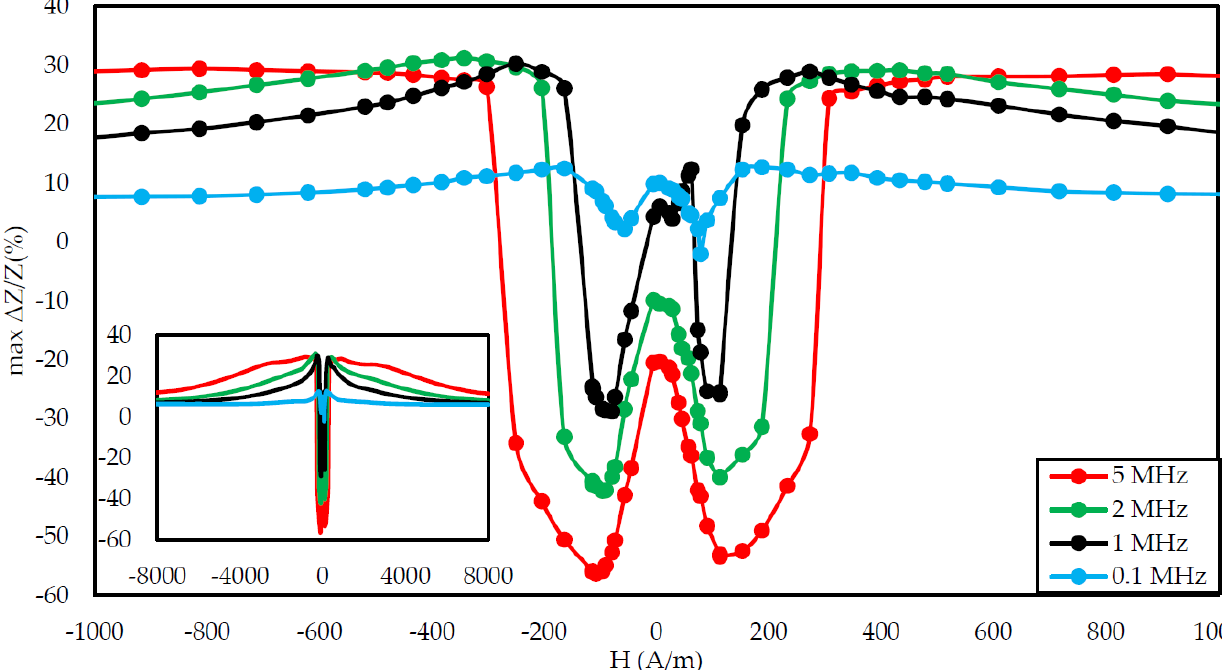
Figure 11. Dependence of max change of impedance ratio in a function of magnetizing field for different driving frequencies for the annealed by a 900 mA current sample.